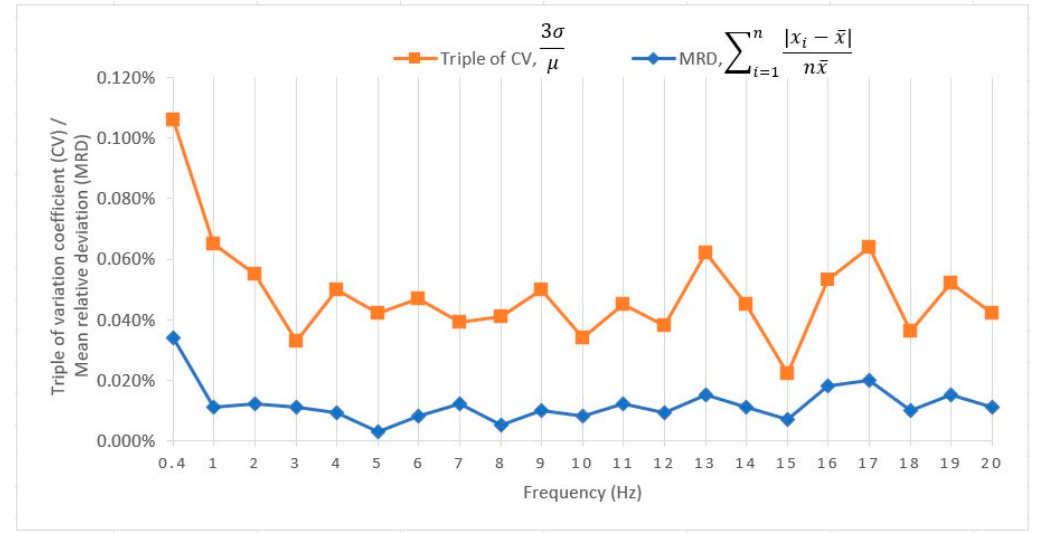
Figure 9. Frequency measuring results of signals generated by signal generator.